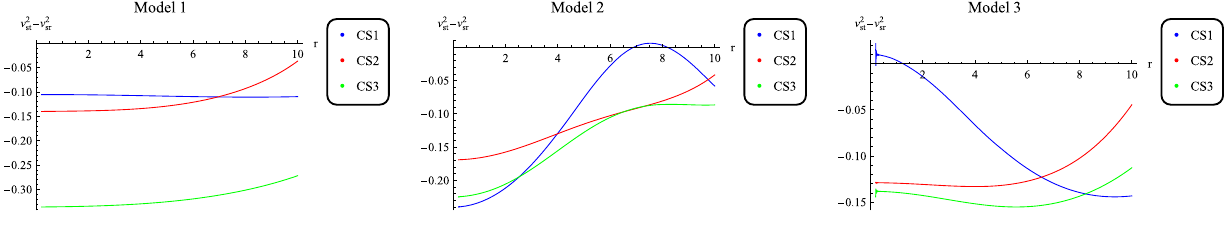
Fig. 11 Variations of v 2 st − v 2 sr with respect radius, r (km)